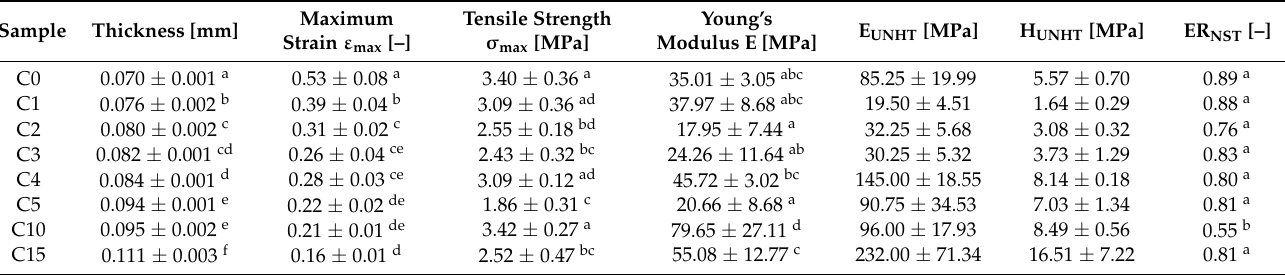
Table 1. Mechanical